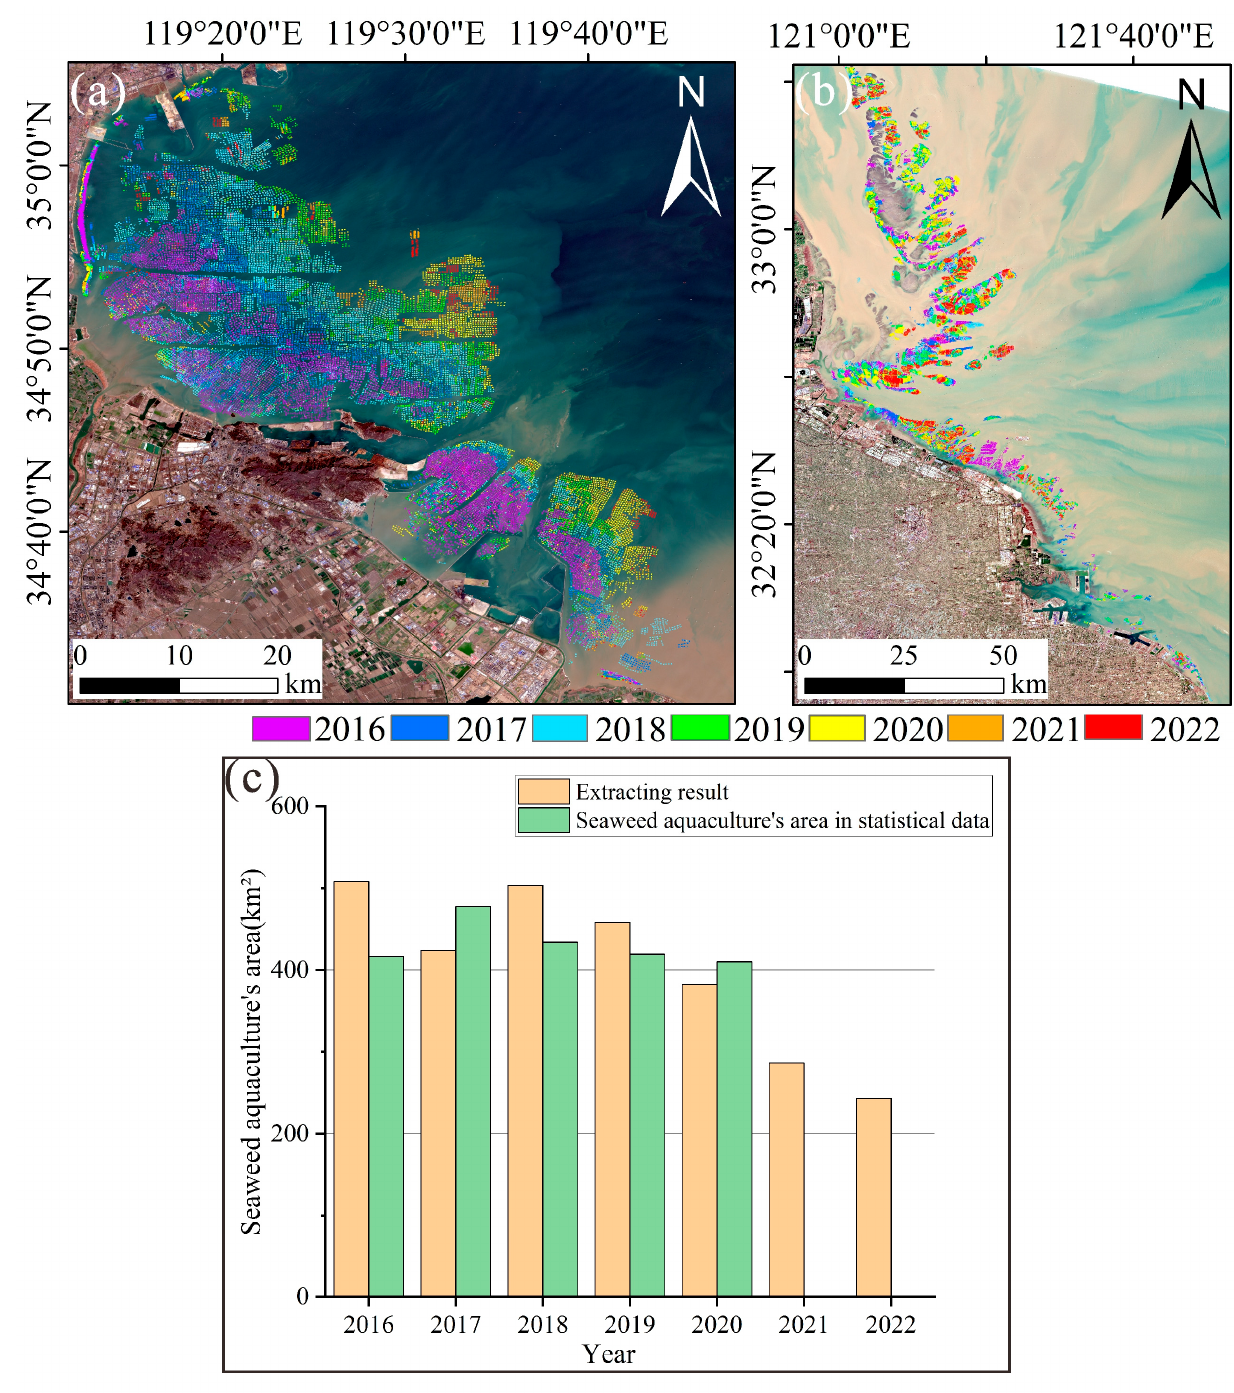
Figure 4. Spatial change of seaweed aquaculture (2016–2022) ( a , b ) and comparison of extraction results and statistical data of seaweed aquaculture and culturing raft from 2016 to 2022 ( c ) the data for 2021–2022 has not been announced